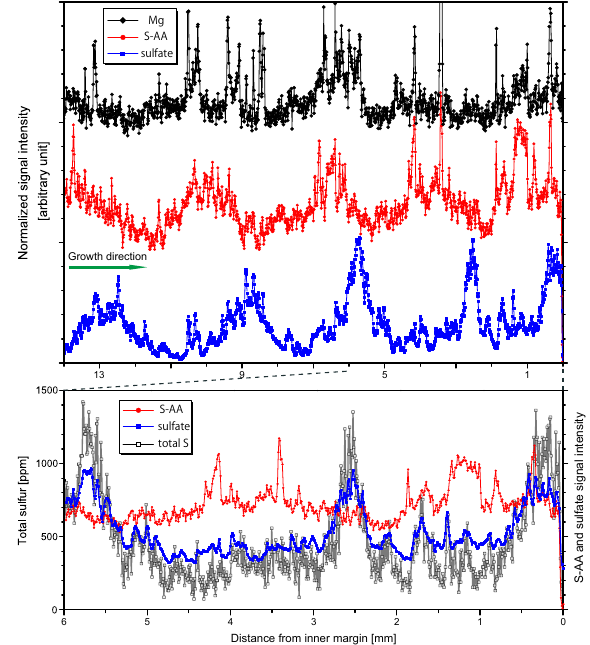
Figure 3. Upper panel: profiles of two different sulfur species, S- bearing amino acids (S-AA, red) and sulfate (blue), and Mg in the inner shell layer of H. hippopus , obtained by the µ -XRF/XAS method at 10µm measurement intervals. Lower panel: total sulfur concentration measured at 8µm intervals compared with sulfur spe- ciation profiles. The cyclic fluctuation of total sulfur correlated well with that of